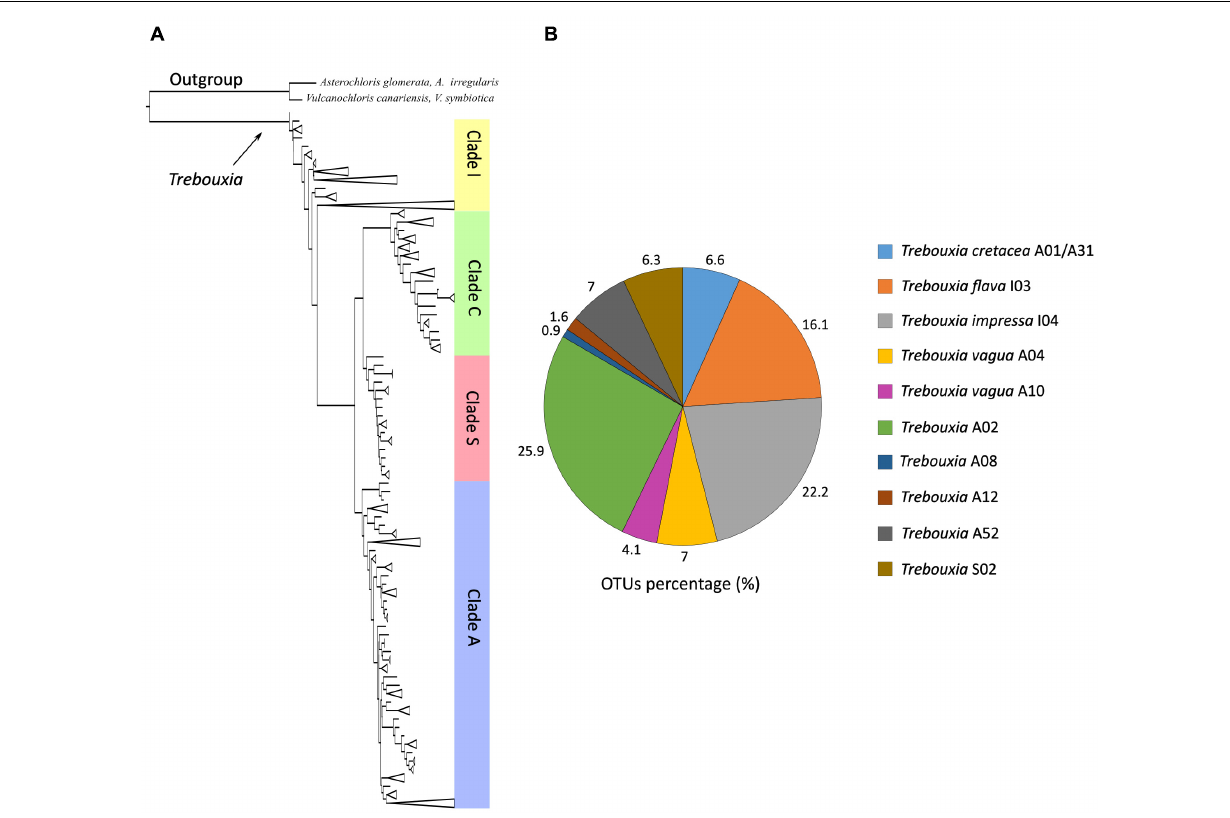
FIGURE 1 | (A) Schematic ML and Bayesian phylogenetic hypothesis based on the ITS locus of Trebouxia genus including the newly generated sequences. The definition of the major clades follows the multi-locus phylogeny of Muggia et al. (2020). (B) Relative abundances of Trebouxia species-level lineages recovered in this